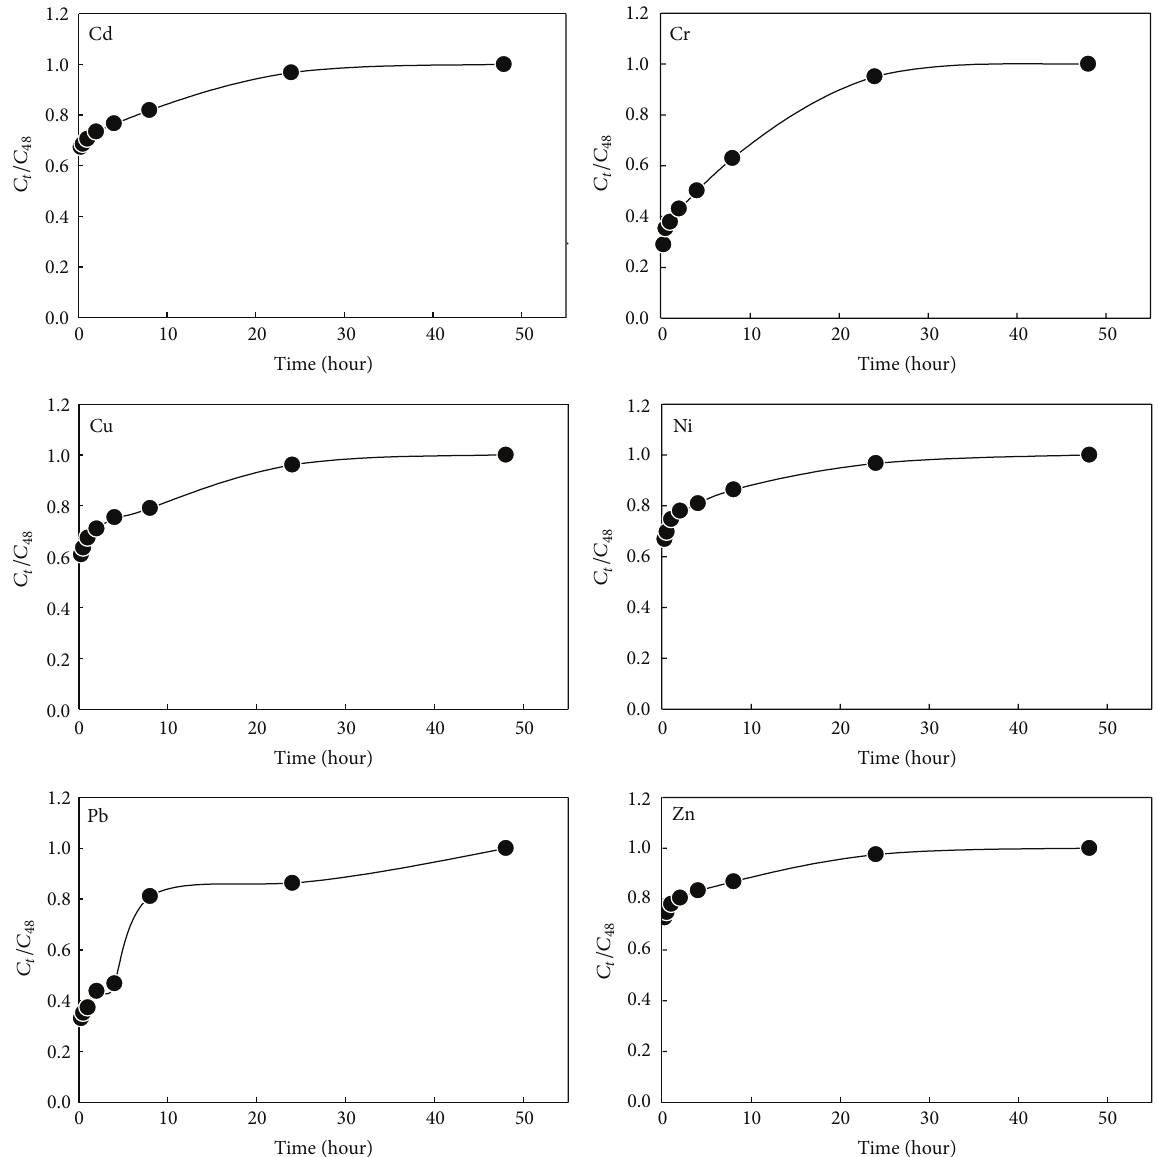
Figure 3: Time-dependent Cd, Cr, Cu, Ni, Pb, and Zn dissolutions of the biosolid-treated Romona soil (1,080Mgha −1 ) in 0.1 M organic acid mixtures ( 𝐶 𝑡 denotes concentration at time 𝑡 and 𝐶 48 denotes concentration at 48